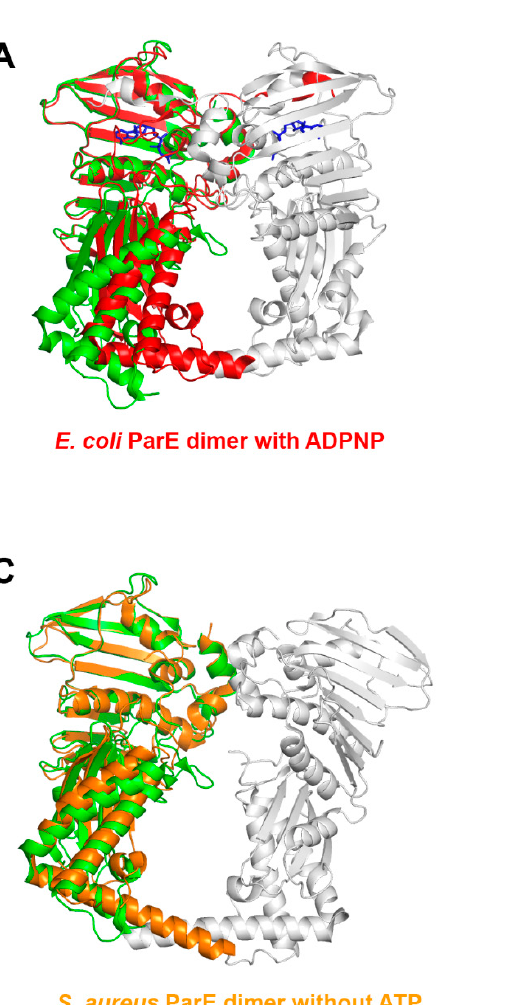
Figure 2. Structural comparison of ParE ATPase domains. ( A ) Comparison of Xoo ParE (green) with the dimeric structure of E. coli ParE (red and gray, PDB code 1S16) in complex with ADPNP (blue). ( B ) Comparison of Xoo ParE (green) with the dimeric structure of S. pneumoniae ParE (purple and gray, PDB code 5J5Q) in complex with ADPNP (blue) and a DNA duplex (cyan). ( C) Comparison of Xoo ParE (green) with the apo structure of S. aureus ParE dimer (orange and gray, PDB code 3URL). ( D ) Comparison of Xoo ParE (green) with the monomeric structure of F. tularensis ParE (yellow, PDB code 4HXZ).